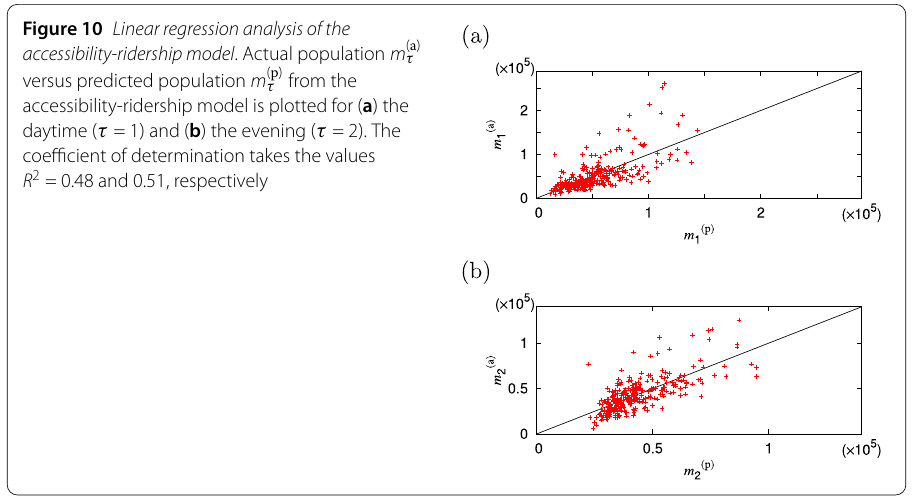
Figure 10 Linearregressionanalysisofthe accessibility-ridershipmodel . Actual population m ( a ) τ versus predicted population m ( p ) τ from the accessibility-ridership model is plotted for ( a ) the daytime ( τ = 1) and ( b ) the evening ( τ = 2). The coefficient of determination takes the values R 2 = 0.48 and 0.51,